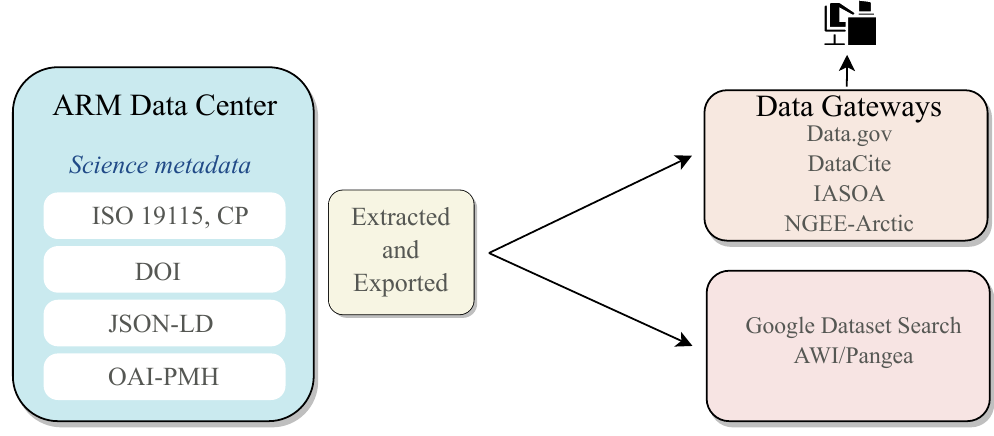
Figure 7. Meta sharing in external portals (Source: